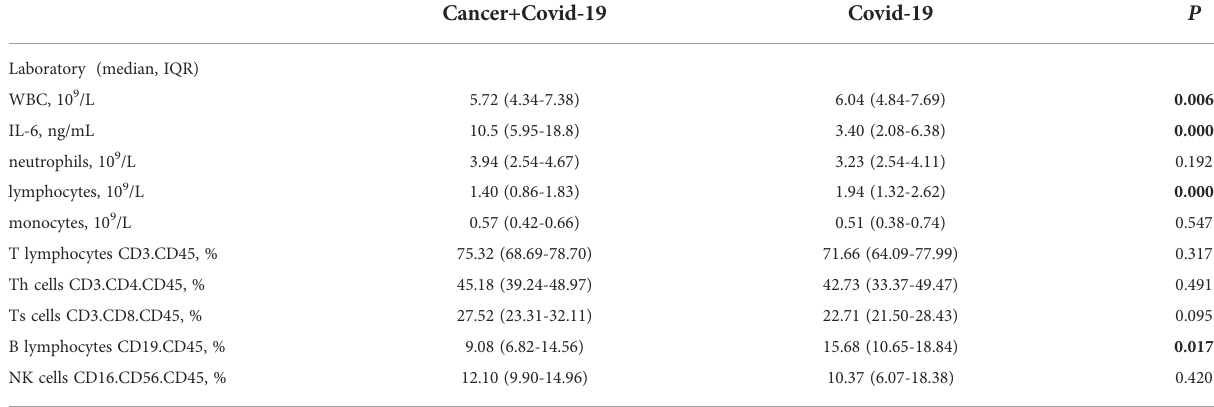
TABLE 3 Leukocyte and Lymphocyte Subpopulations of cancer patients with COVID-19 and COVID-19 patients.